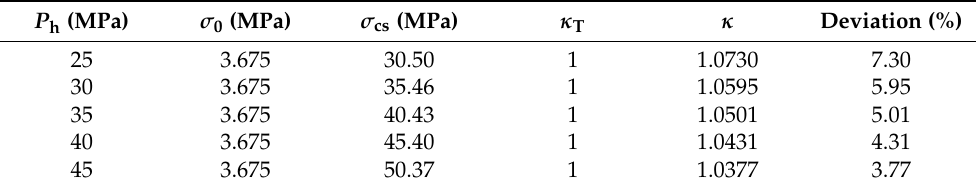
Table 1. Theoretical and FEA results of the linear scaling factor. P h